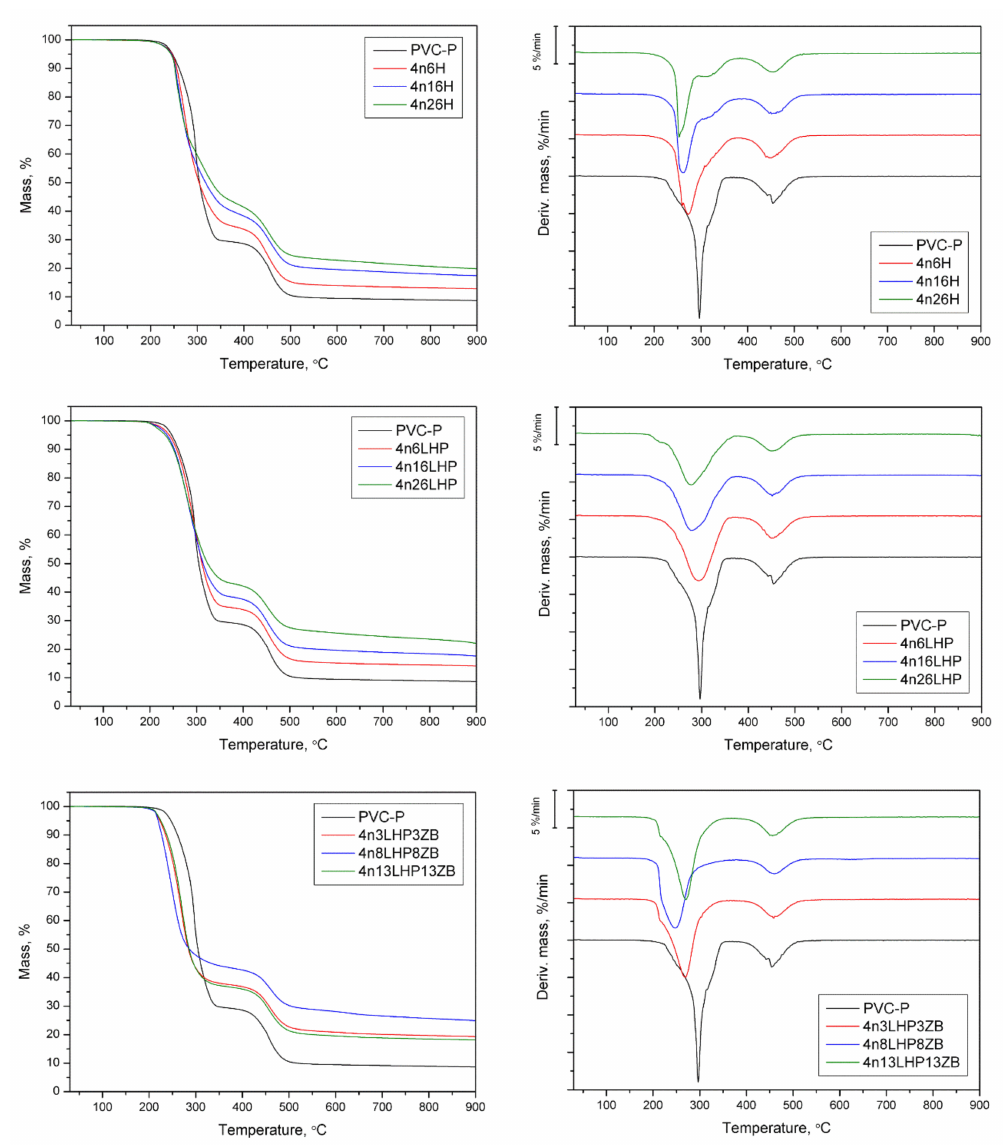
Figure 6. TG and DTG curves of PVC-P, PVC/APP, and PVC/FRSs under an inert